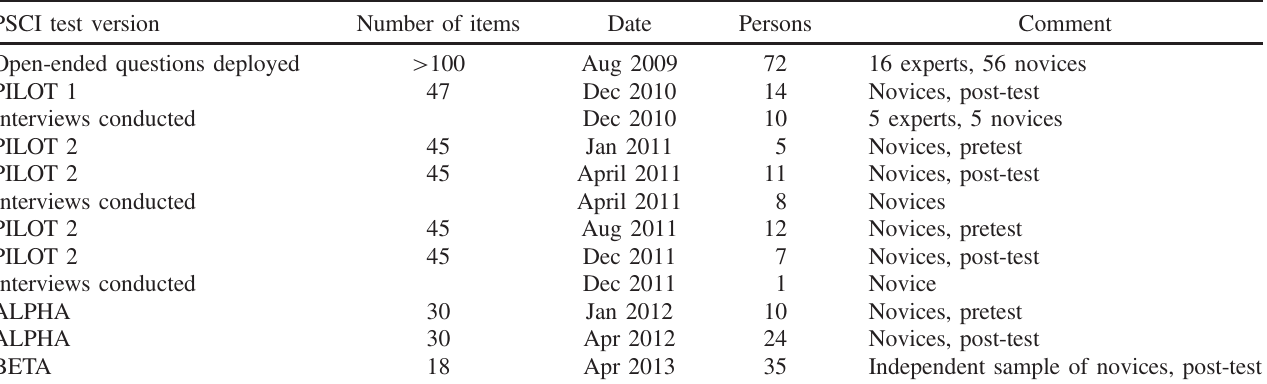
TABLE I. Chronological development of the PSCI and schedule for test administration.